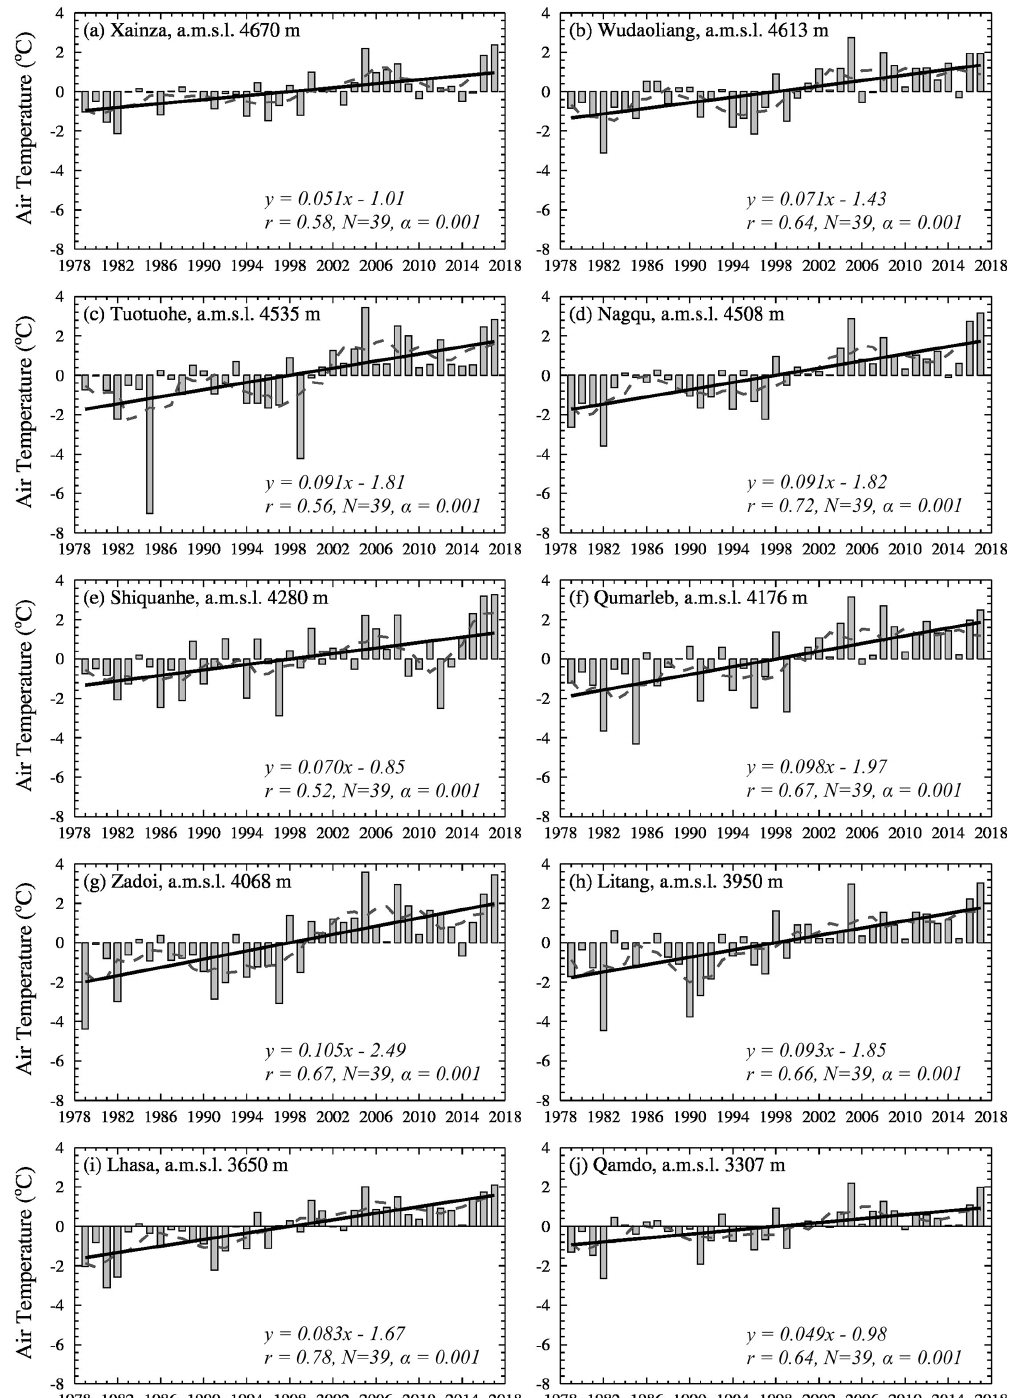
Figure 2. Trends of observational winter (December–January–February) mean temperature anomaly recorded by 10 weather stations over the Tibetan Plateau during the last 4 decades